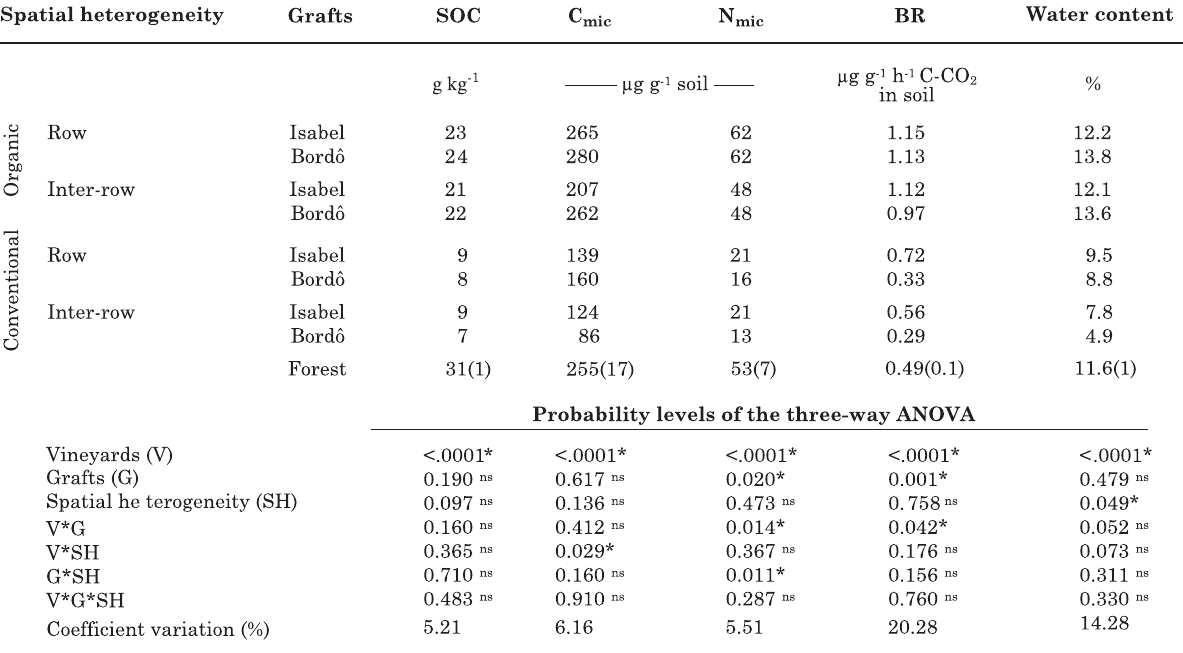
Soil was sampled from a 0–10 cm layer. All values are means of four repetitions. P- values followed by ns: not significant by Tukey’s test (p < 0.05). Data from forest were not included in the statistical analyses, standard deviation in